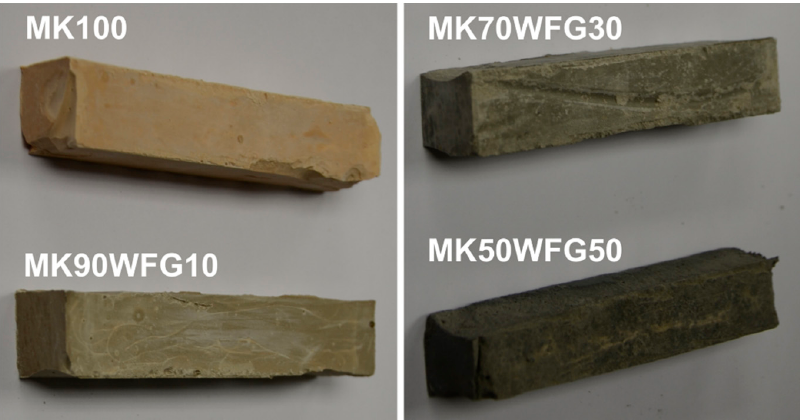
Figure 4. Appearance of the 28-day cured specimens.